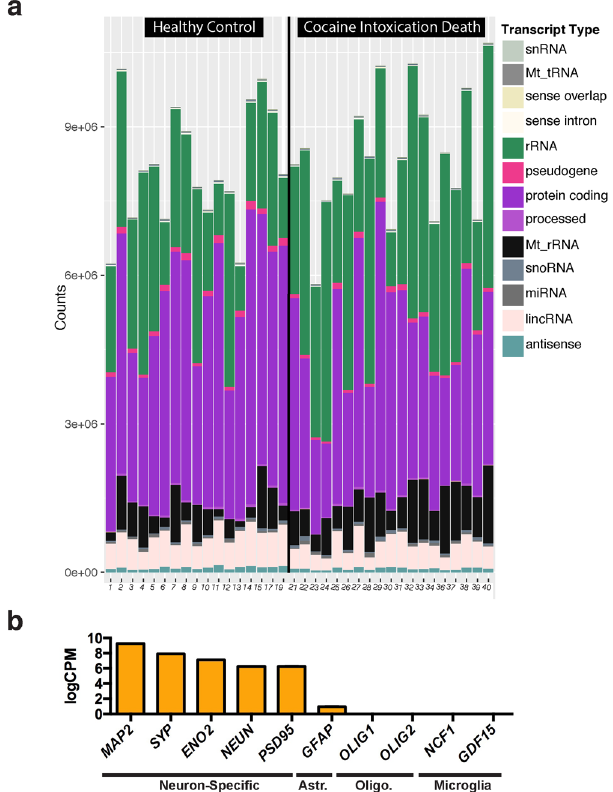
Figure 1. Cell type-specific total RNA-sequencing in human post-mortem dlPFC neuronal nuclei. ( a ) Quantification of read counts for each transcript type that was detected using RNA-sequencing. Healthy controls are shown on the left while cocaine cases are on the right. We did not detect any statistically significant differences in abundance of transcript types across cases and controls. ( b ) Neuron-specific transcripts are highly expressed, including microtuble associated protein 2 ( MAP2 ), synaptophysin ( SYP ), enolase 2 ( ENO2 ), neuronal nuclear protein ( NEUN , also known as RBFOX3 ) and postsynaptic density 95 ( PSD95 ). The astrocyte specific protein, glial fibrillary acidic protein ( GFAP ) was expressed at several orders of magnitude lower levels, while microglial and oligodendrocyte specific transcripts ( OLIG1 /2, oligodendrocyte transcription factor 1/2; NCF1 , neutrophil cytosolic factor 1; and GDF15 , growth differentiation factor 15) were not detected. Y-axis is log counts Per million. Standard error of the mean is shown. Astr. – Astrocyte-specific, Oilgo. – Oligodendrocyte-